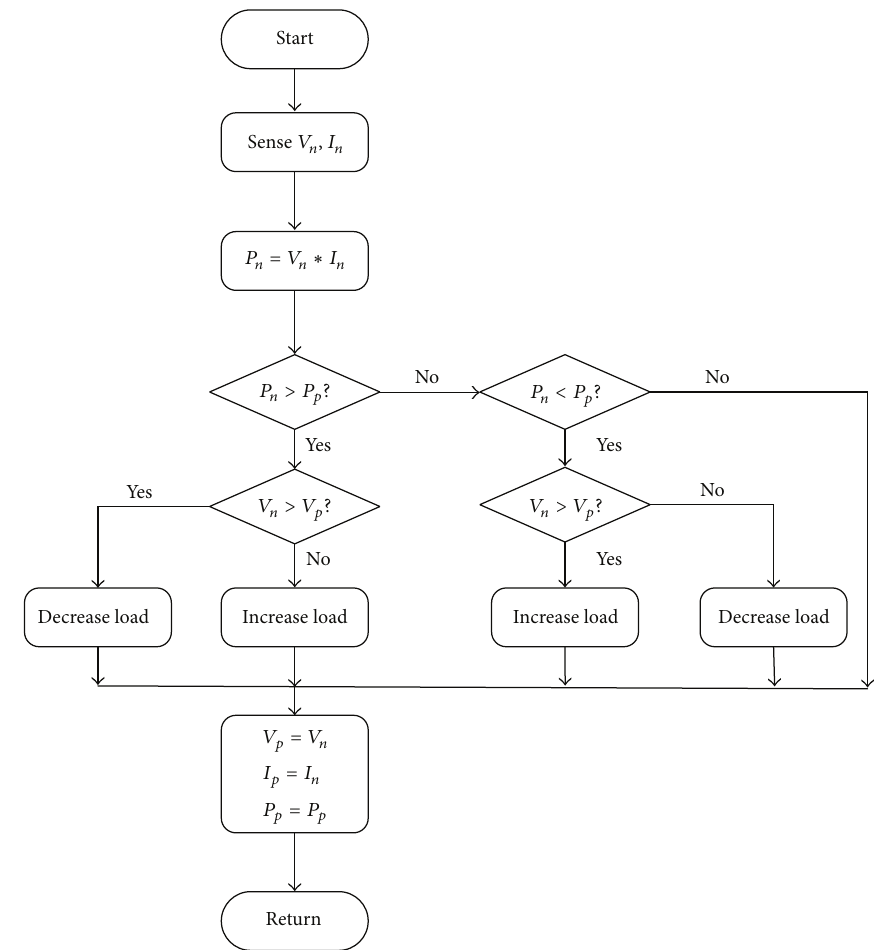
Figure 9: The flowchart of perturb-and-observe method to achieve MPPT feature.